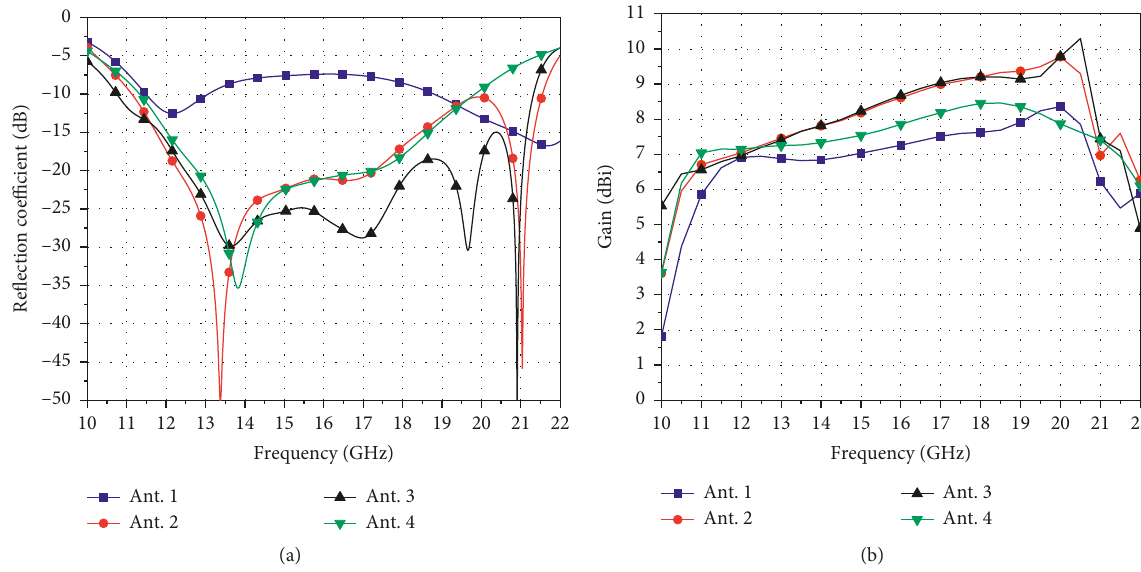
Figure 3: Simulated active reflection coefficient and gain in the evolution of the antennas. (a) Reflection coefficient. (b) Realized gains.